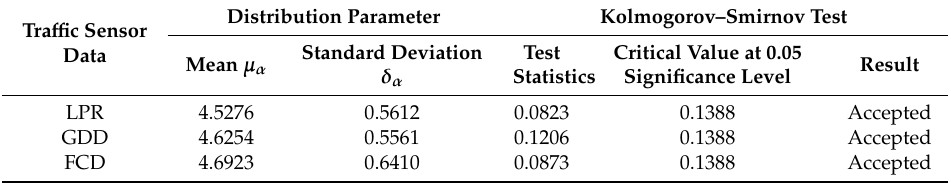
Figure 6. Probability histogram and PDF curve of average travel time based on floating car data (FCD).